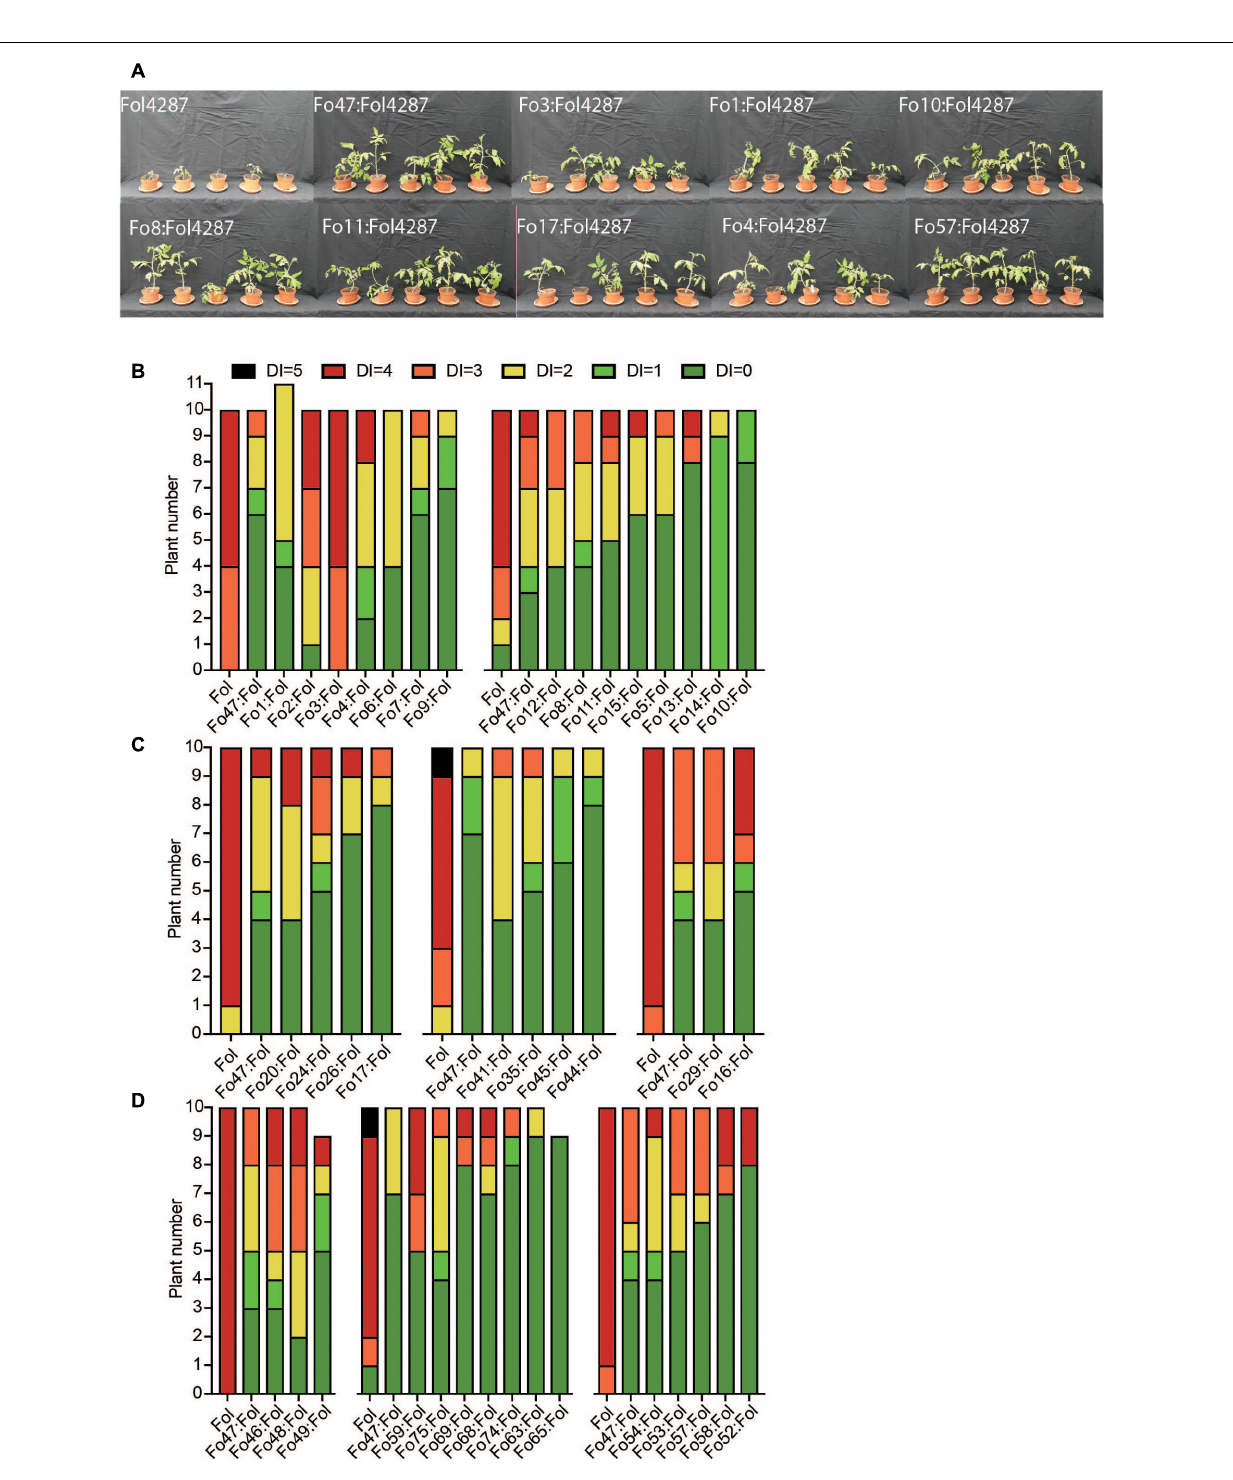
FIGURE 1 | Most Fo strains trigger Fusarium wilt resistance in tomato to a similar level as Fo47. (A) Pictures of representative tomato plants 3 weeks after inoculation with Fol4287 alone or together with the endophytic strain Fo3, Fo1, Fo4, Fo10, Fo8, Fo11, Fo17, or Fo57. Most Fo strains trigger resistance against Fusarium wilt in tomato to a similar level as Fo47. Disease symptoms of tomato plants inoculated with Fol4287 or co-inoculated with Fo strains from (B) Australian soils, (C) grass roots from Spain or (D) tomato plants from the United States. Data were analyzed by Kruskal–Wallis test using Fo47:Fol4287 treatment as control group and corrected for multiple comparisons using Dunn’s